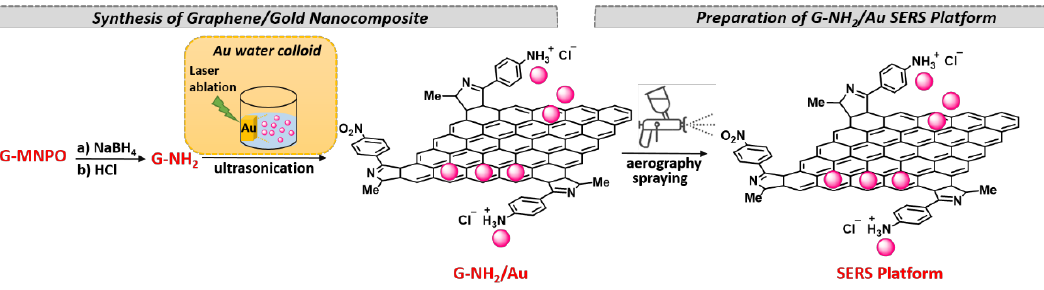
Figure 2. Preparation of G-NH 2 / Au surface enhanced Raman spectroscopy (SERS) platform.